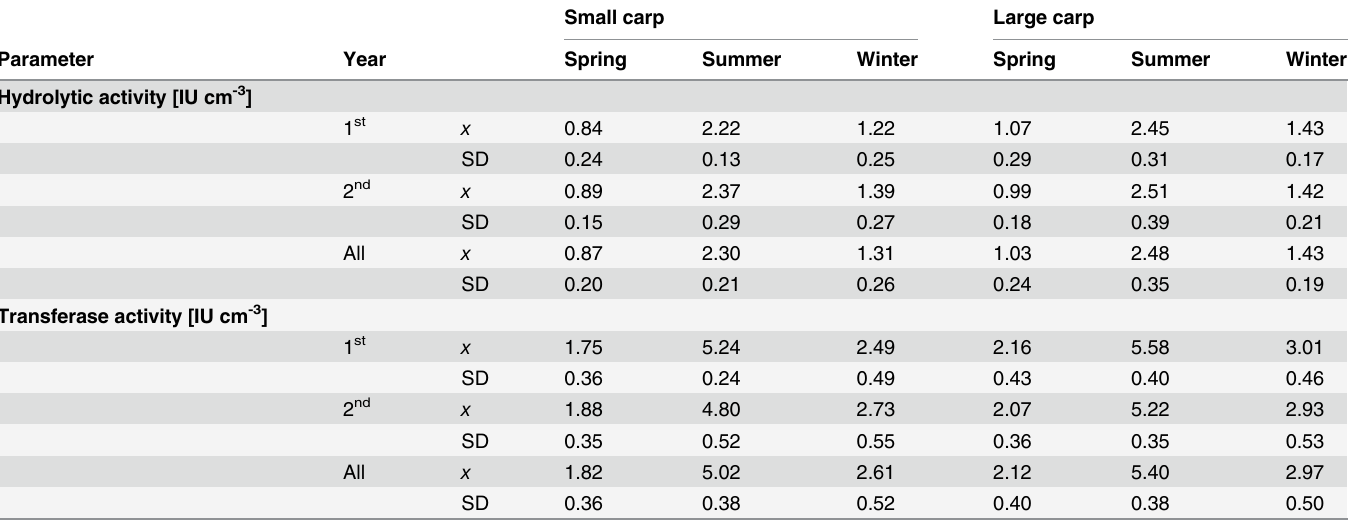
Table 2. Seasonal activity of neutral α